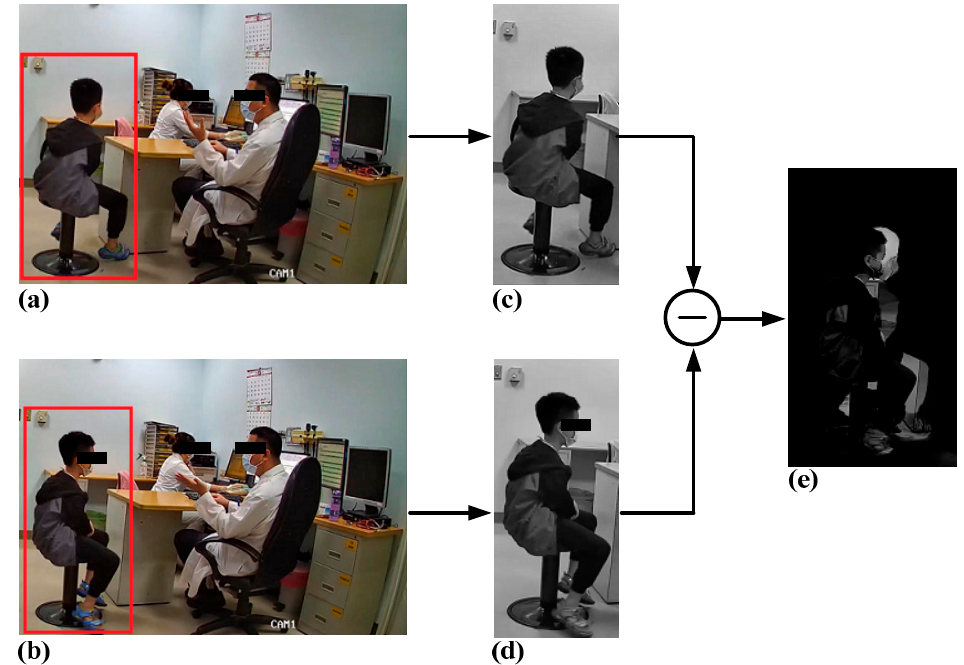
Figure 1. Flow chart of the pixel subtraction method. ( a ) First input color image. ( b ) Second input color image. ( c ) First grayscale image. ( d ) Second grayscale image. ( e ) Subtracted image.